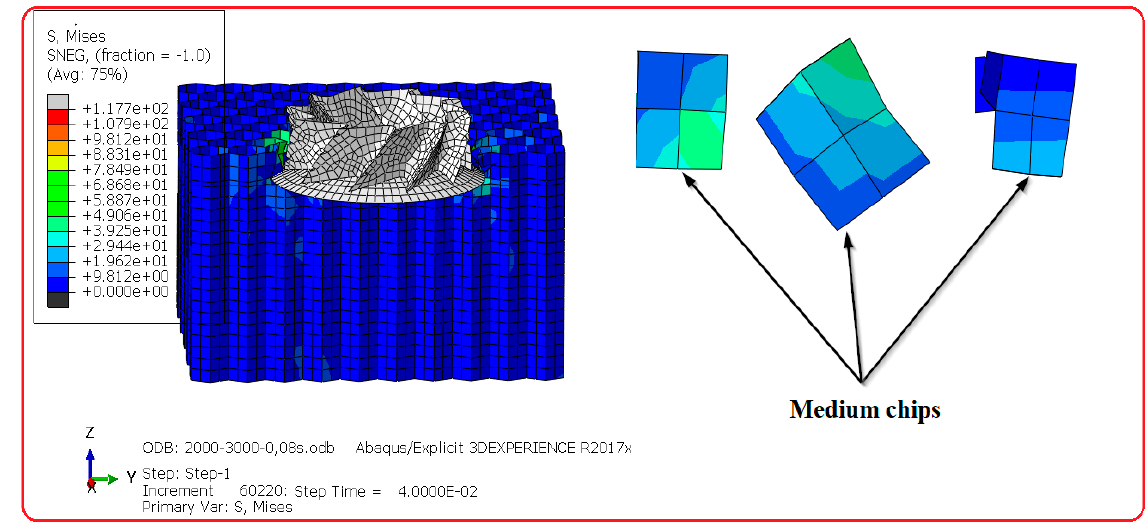
Figure 12. Resulting chip size by the diameter-cutting blade of 16.3 mm.